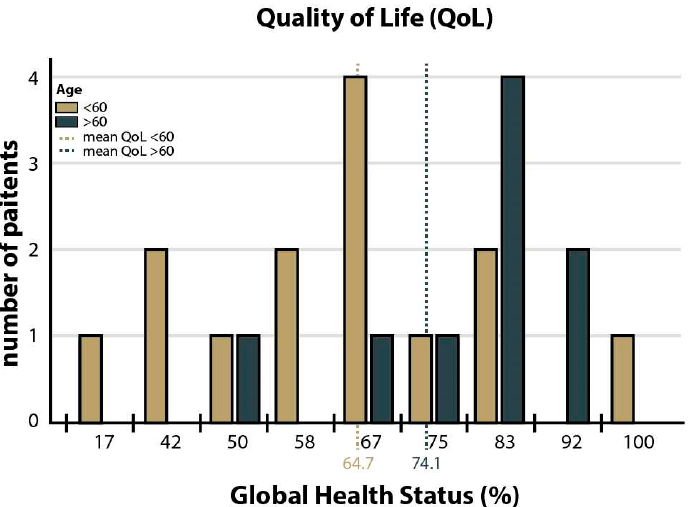
Figure 4. Global health status (GHS) stratified by age. X-axis: GHS in %. Y-axis: number of patients. The global health status (GHS) of PCNSL patients after high-dose chemotherapy followed by autologous stem cell transplantation (HDC/ASCT) in the EORTC QLQ-C30 questionnaire. An averaged GHS of 68.82% (range 17–100%) was documented. Stratified by age, 64.72% ( ≤ 60 years) and 74.14% (>60 years), no significant difference is seen ( p = 0.241).